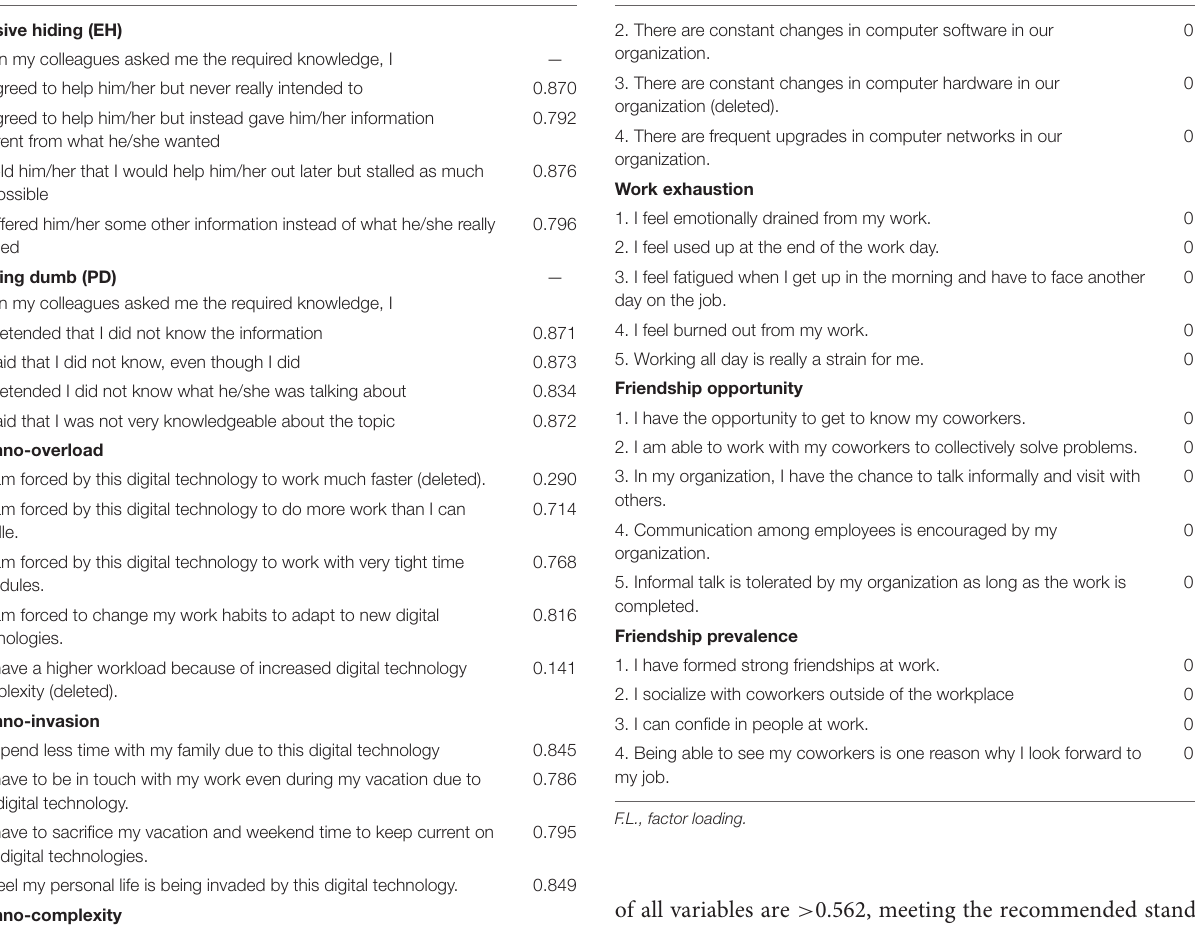
TABLE 3 | The constructs, items, and measurement model ( N = 254). Construct and